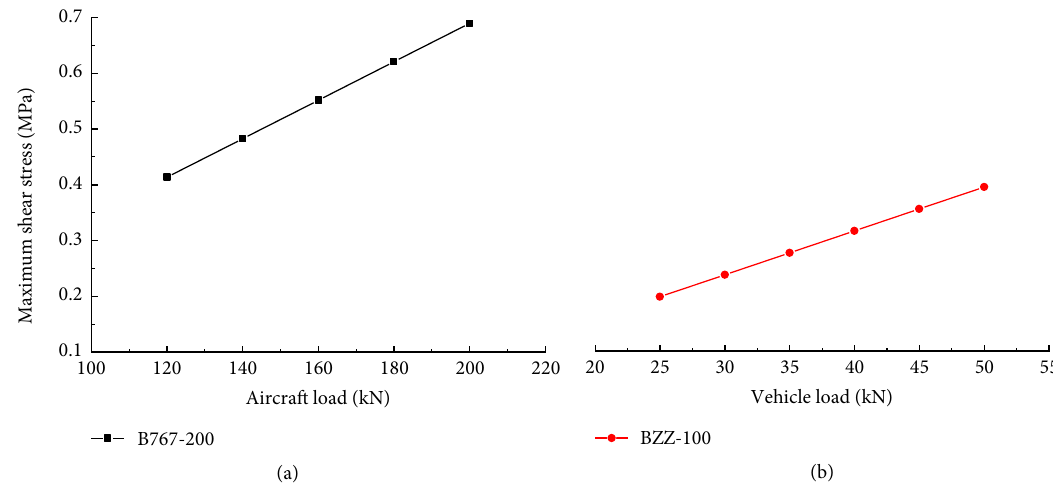
Figure 7: Effect of load on maximum shear stress of overlay: (a) B-767-200, (b) BZZ-100.